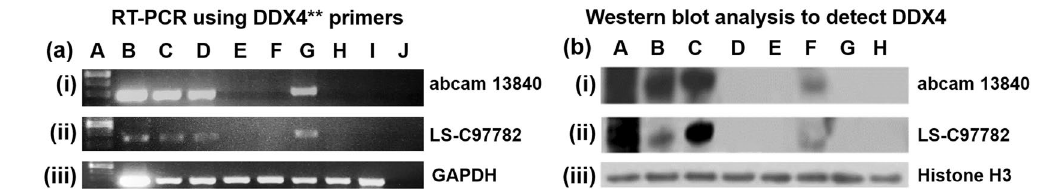
Figure 2. RT-PCR and immuno-blotting of FACS-isolated cell populations. ( a ) RT-PCR of DDX4 gene expression in human ovarian cells and pFLAG-DDX4-myc transfected HEK 293T cells using both DDX4 antibodies (i, samples FACS sorted using the abcam 13840 antibody and ii, samples FACS sorted using the LS-C97782 antibody). When using primers cited by Anderson et al . 27 . DDX4 expression was detected in dissociated human ovarian cells (i,iiC) and in DDX4-positive sorted human ovarian cells (i,iiD) but not in DDX4-negative sorted human ovarian cells (i,iiE). DDX4 transfected HEK 293T cells sorted in the positive gate showed positive DDX4 expression (i,iiG) but untransfected HEK293T cells (i,iiF) and transfected HEK 293T cells sorted in the negative gate showed no DDX4 expression (i,iiH). Rat skeletal muscle was used as a negative control and showed no gene expression (i,iiI). Reverse transcriptase was omitted from duplicate reactions as negative controls (i,iiJ); internal control: GAPDH (iii); A, ladder, B, template DNA complimentry to DDX4 primers pairs. ** primer sequence from Anderson et al . 27 . Samples were derived from the same experiment and gels were processed in parallel. Full-length gels can be seen in Supplementary Figure S2. ( b ) Western blot analysis of DDX4 protein by two different DDX4 antibodies (i, samples immunoblotted using the abcam 13840 antibody and ii, samples immunoblotted using the LS-C97782 antibody) in sorted adult human ovarian cells and transfected HEK 293T cells. DDX4 was expressed in rodent testes (i,iiA), dissociated human adult ovary (i,iiB), DDX4-positive sorted human adult ovarian cells (i,iiC) and DDX4-positive sorted HEK 293T transfected cells (i,iiF). DDX4 was absent from human adult ovarian DDX4-negative sorted cells (i,iiD), untransfected HEK 293T cells (i,iiE), DDX4 negative sorted HEK 293T transfected cells (i,iiG) and rat skeletal muscle (i,iiH; which was used as a negative control); Histone H3 was used as an internal protein loading control. Full-length blots are presented in Supplementary Figure